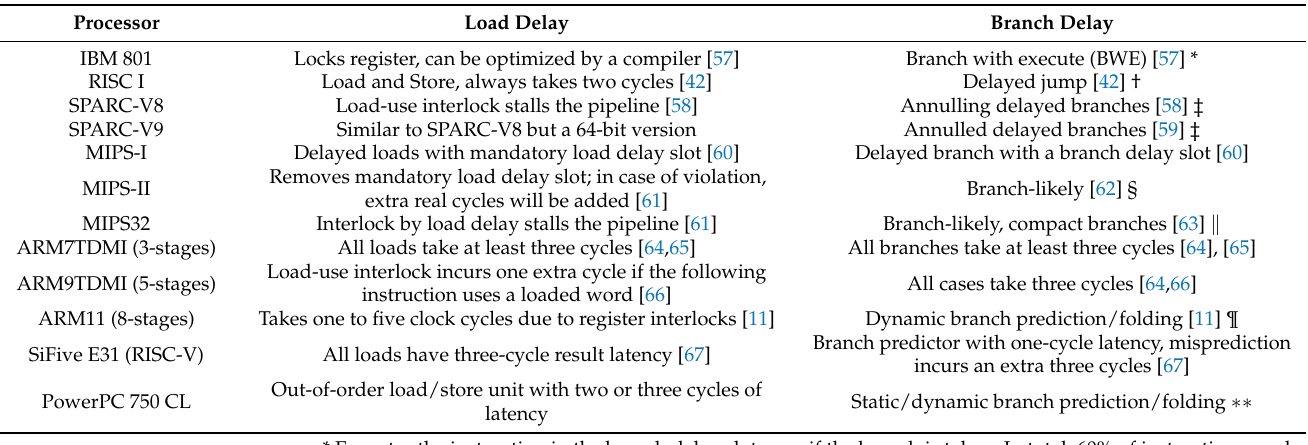
Table 1. RISC Solutions to Load and Branch Delays.